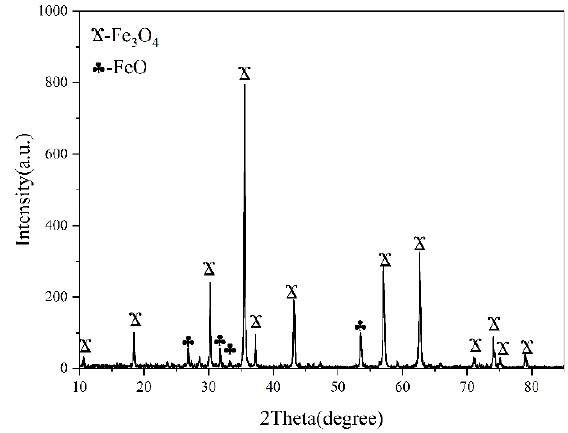
Figure 1. XRD of iron ore concentrate